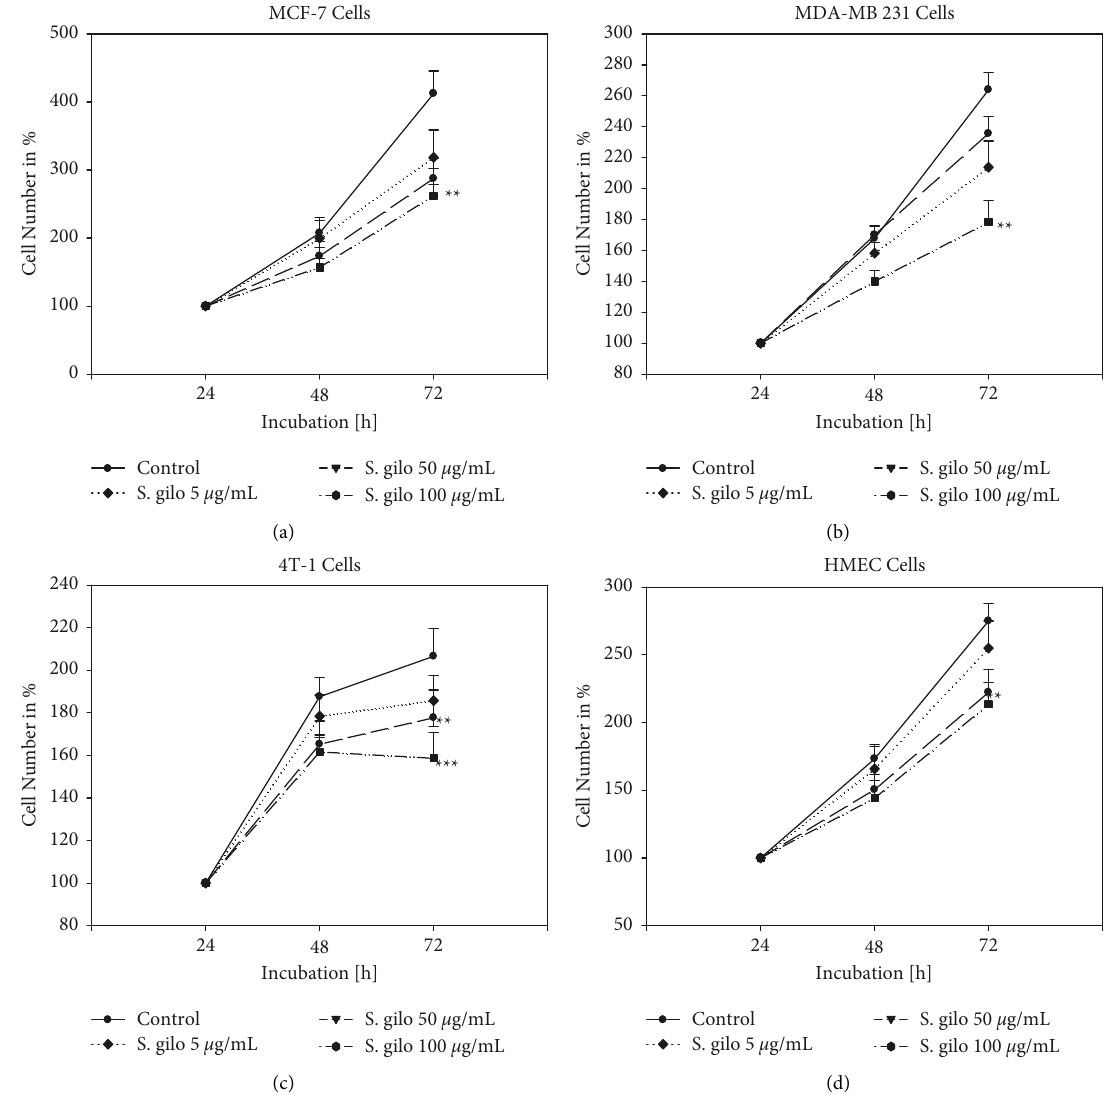
Figure 1: Growth of MCF-7 (a), MDA-MB 231 (b), 4T-1 (c), and HMEC (d) cells. Cells were treated with different concentrations of Solanum gilo hydroethanolic extract for 24, 48, and 72 hours. Controls remained untreated ( n � 3). Treated tumor cell cultures were compared to nontreated control cultures of the same passage and cell numbers per well. ∗∗ p < 0 . 05 and ∗∗ p < 0 . 01 as compared to untreated control